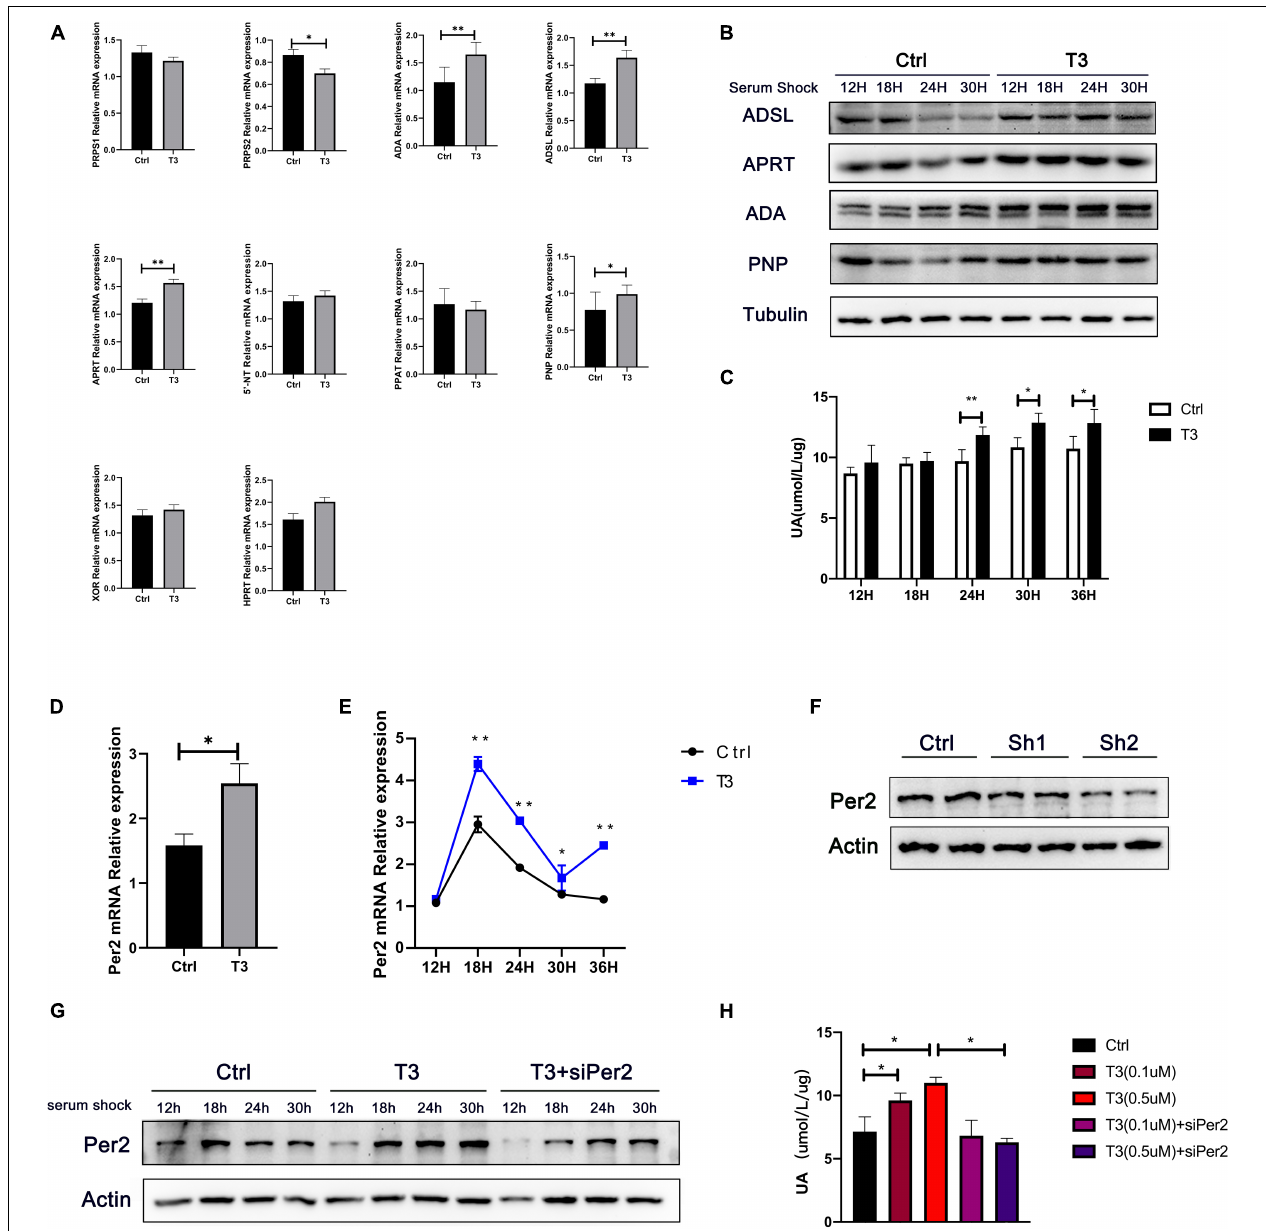
FIGURE 3 | (A) mRNA levels of enzymes involved in nucleotide metabolism in mouse liver, Actb was chose as the housekeeping genes to normalize the qPCR results. (B) Protein levels of ADSL, APRT, PNP, and ADA in HepG2 cells after serum shock. (C) Urate levels in cell culture supernatant at different points after serum shock. (D) Per2 mRNA levels in liver after T3 treatment, Actb was chose as the housekeeping genes to normalize the qPCR results. (E) Per2 mRNA levels in HepG2 cells at different time points after serum shock, Actb was chose as the housekeeping genes to normalize the qPCR results. (F) Protein levels at 48 h